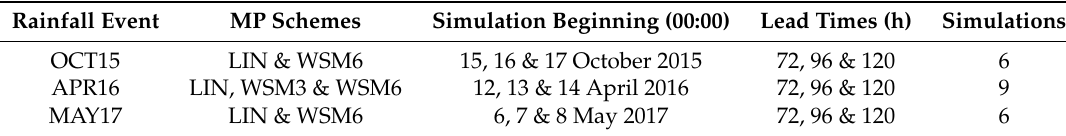
Table 3. Final WRF simulations with different lead times and MP